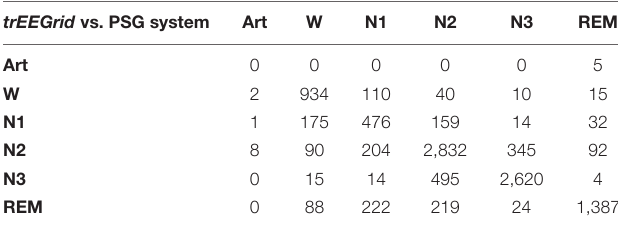
trEEGrid vs. PSG